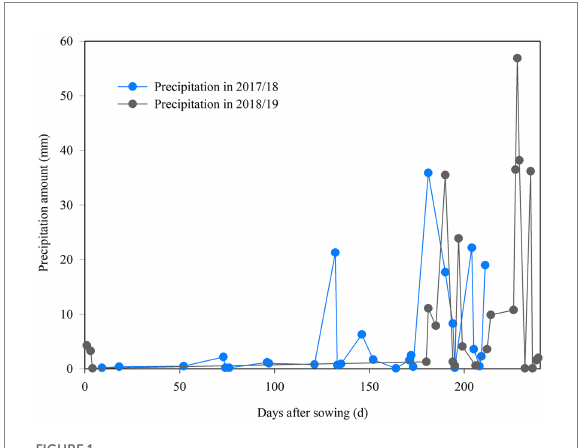
FIGURE 1 Daily precipitation during the winter wheat-growing seasons in 2017/18 and